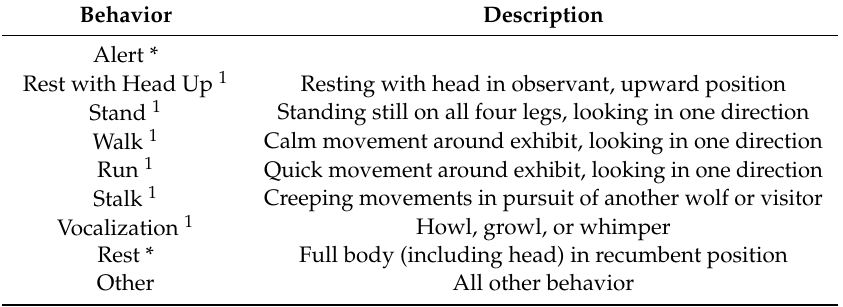
Table A1. Wolf ethogram, with behaviors of focus indicated with an asterisk